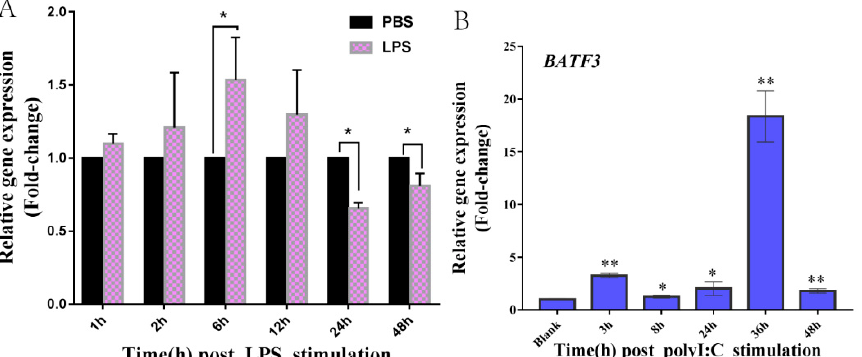
Figure 5. The expression patterns of CiBATF3 in CIK cells after LPS ( A ) or poly(I:C) ( B ) challenge. CIK cells were stimulated with poly(I:C) (20 μ g mL − 1 ) and LPS (10 μ g mL − 1 ), respectively. Untreated cells served as controls. The expression level of the control group was set as the baseline (1.0) and the results are presented as the mean ± SD ( n = 3). * = p ≤ 0.05, ** = p ≤ 0.01.